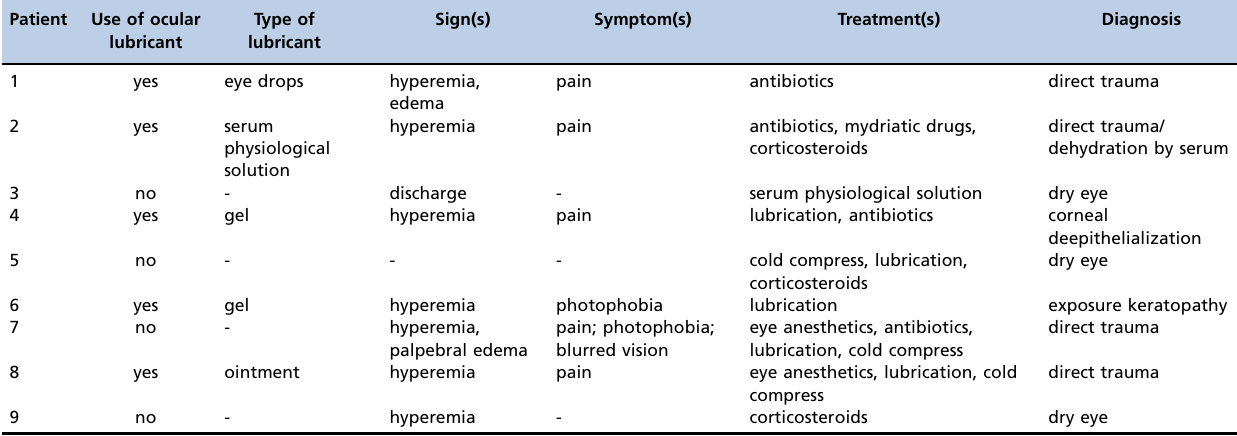
Table 2 - Description of ocular findings (signs and symptoms), treatments and final diagnoses for patients subjected to general anesthesia. Patient Use of ocular